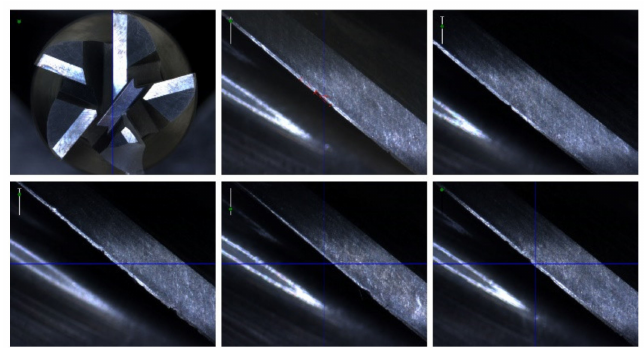
Figure 27. Tool wear for constant F .